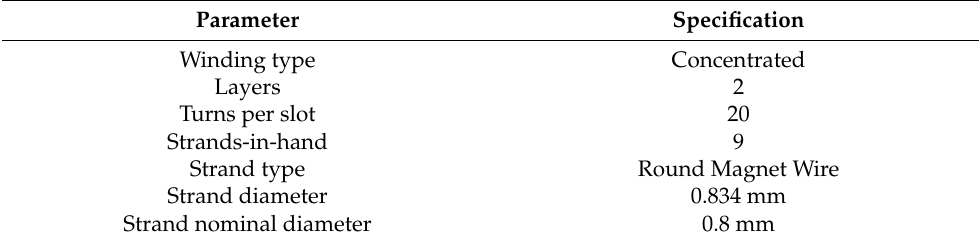
Figure 1. ( Left ) Finite element model of the machine motorette with strand-level winding. ( Right ) Representation of conductor layout and positions in the half side of a slot of the motorette. Table 2. Motorette parameter and